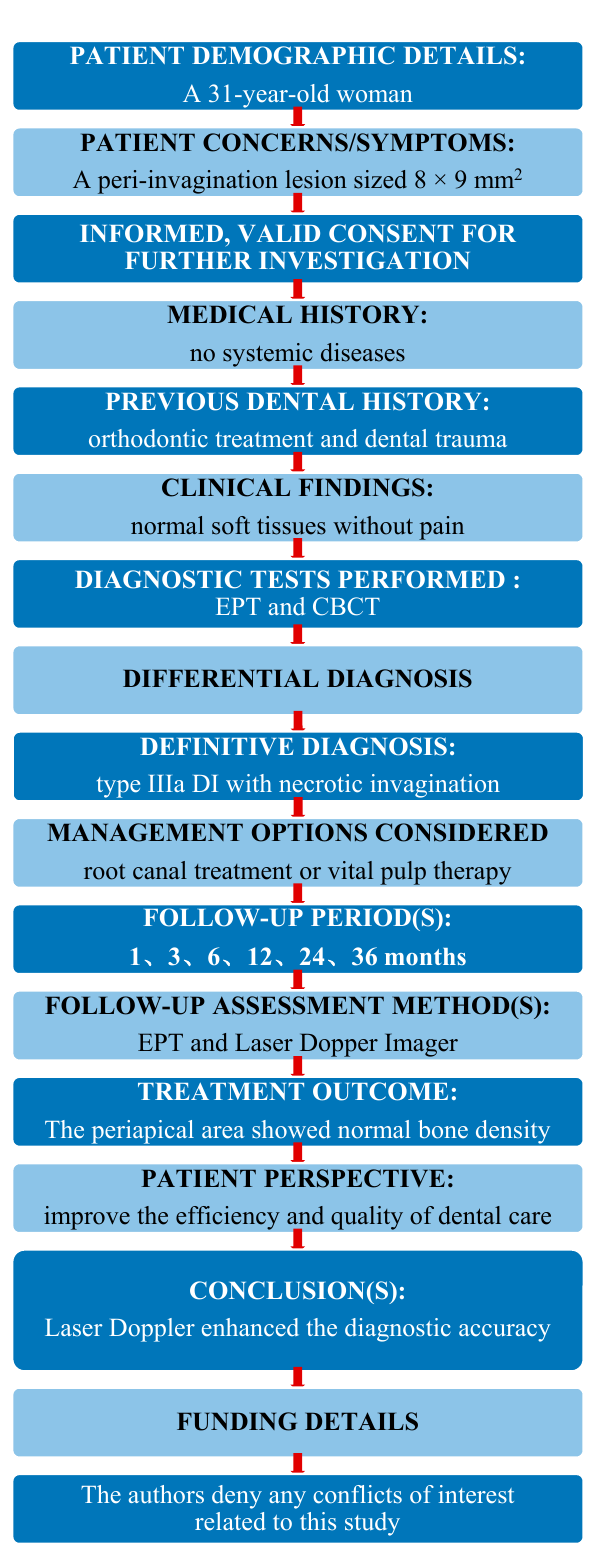
Figure 6. The PRICE 2020 flowchart showing the steps involved in the case report. *From: Nagen- drababu V, Chong BS, McCabe P, Shah PK, Priya E, Jayaraman J, Pulikkotil SJ, Setzer FC, Sunde